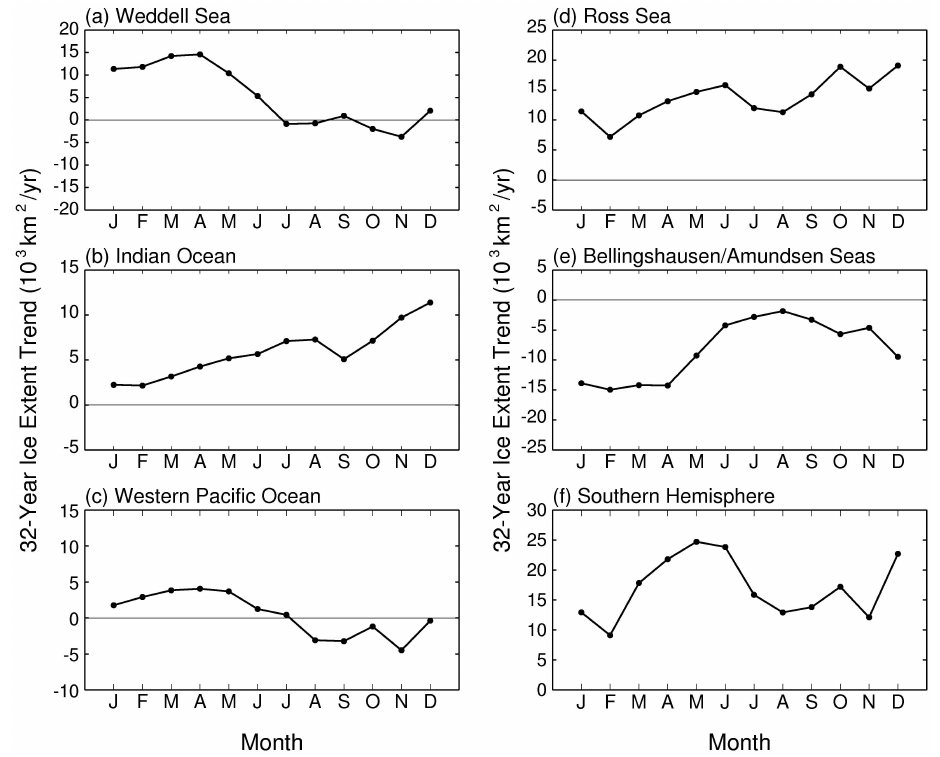
Fig. 5. Monthly sea ice extent trends, 1979–2010, for the following regions and hemispheric total: (a) Weddell Sea, (b) Indian Ocean, (c) western Pacific Ocean, (d) Ross Sea, (e) Bellingshausen/Amundsen Seas, and (f) Southern Hemisphere as a whole.